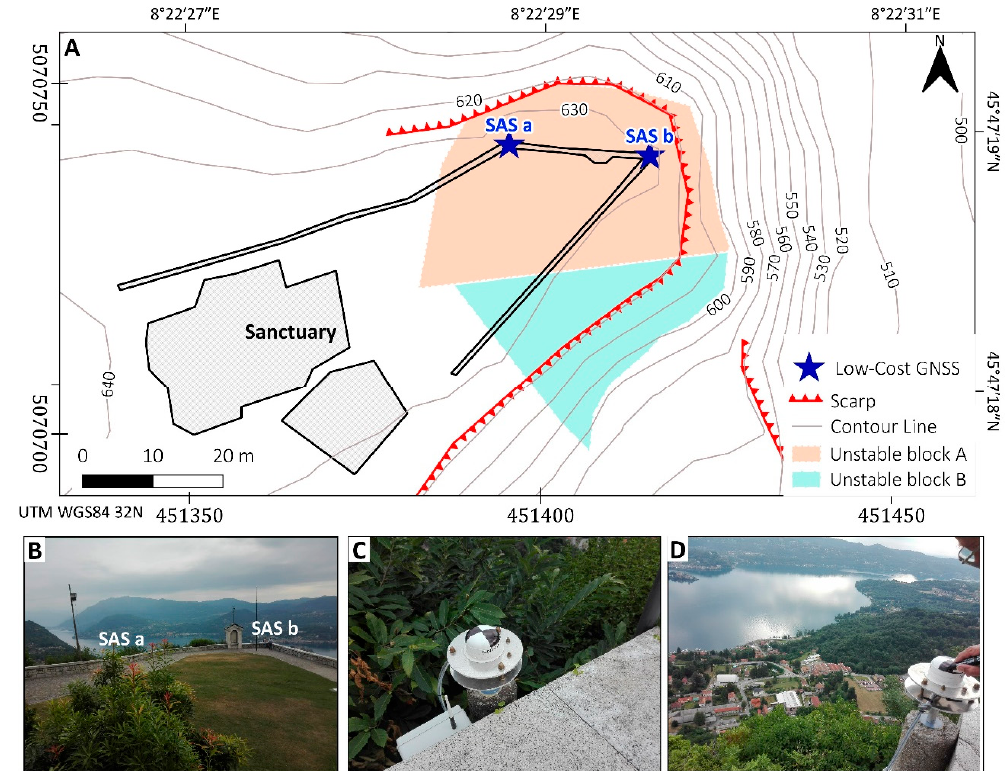
Figure 5. ( A ) shows the location on maps of Global Navigation Satellite System GNSS antennas “SAS a” and “SAS b” with latitude-longitude (upper right) and UTM WGS 84 (bottom left) coordinates; ( B ) a picture shows the location of antennas from the courtyard perspective; ( C ) the photo shows a detail of “SAS a” antenna [451401.968 E, 5070726.618 N, 682.378 h–WGS4 32 N]; ( D ) shows a detail of “SAS b” antenna SAS b [451384.123 E, 5070731.990 N, 683.187 h–WGS4 32